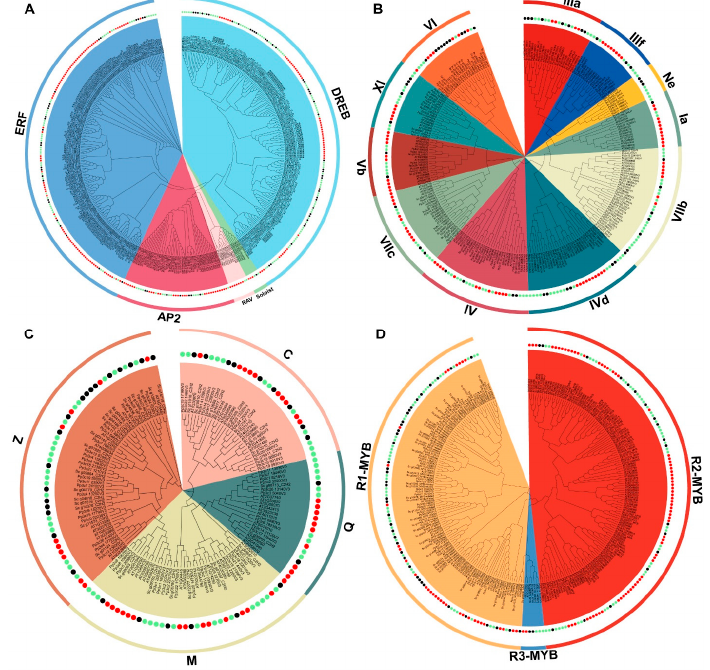
Figure 4. Molecular evolution analysis of the top four TF families in S. caninervis . Phylogenetic tree relationships of ( A ) AP2/ERF proteins. ( B ) bHLH proteins. ( C ) C2H2-zinc finger proteins. ( D ) MYB proteins in S. caninervis , A. thaliana , and P. patens . Black, green, and red dots mark S. caninervis , P. paten , and A. thaliana , respectively.